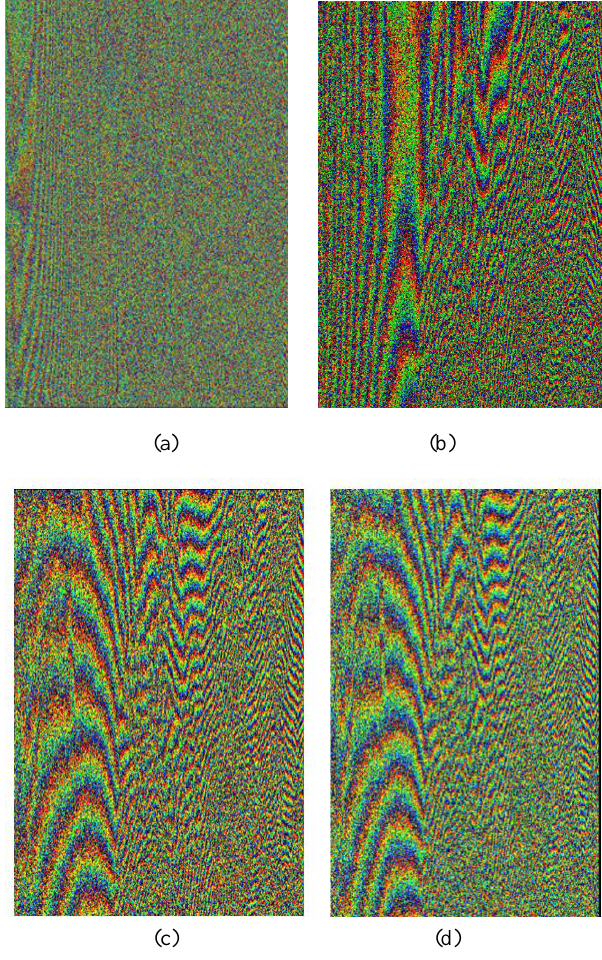
Figure 4: Interferogram with flat-earth removed using (a) Imaging geometry (b) Fitting a 3-degree polynomial (c)Fitting a 5-degree polynomial (d)Fitting a 7-degree polynomial